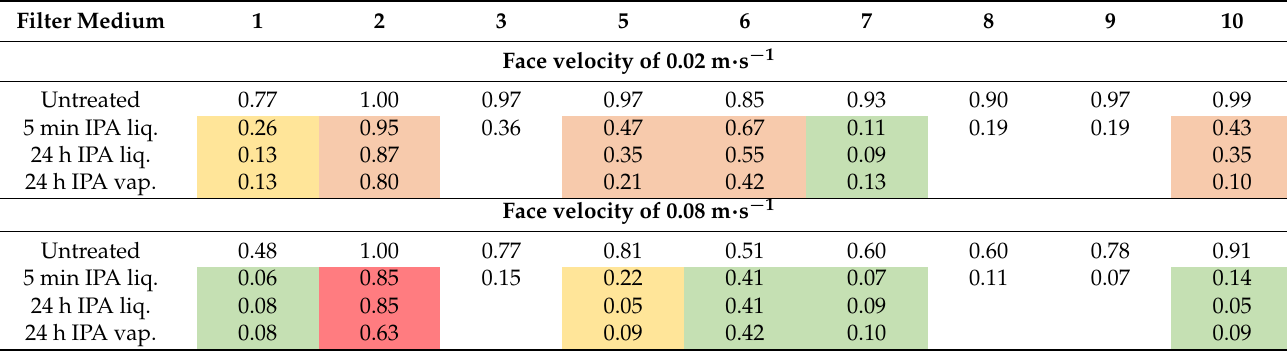
Green: Effect of immersion and vapor discharging comparable already after 5 min. Figure 3c. Orange: Effect of immersion and vapor discharging closer after 24 h than after 5 min, but still different. Figure 3a. Red: Effect of immersion and vapor discharging not comparable even after 24 h. Figure 3b. Yellow: Effect of immersion and vapor discharging comparable only after 24